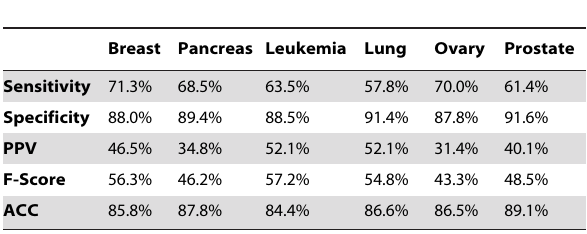
Table 4. Performance assessment of molecular connectivity maps for several representative